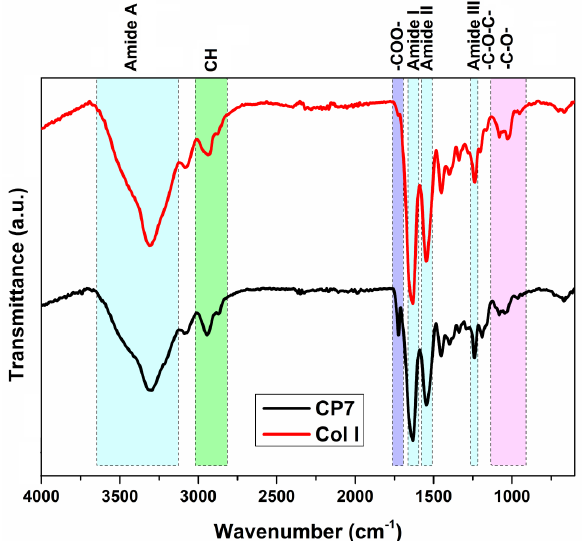
Figure 2. FTIR spectra of commercial collagen and of the CP7 sample (Entry 2, Table 1). The macroporous structure with interconnected pores of cryogel 2 (CP7, Table 1) a lower concentration of components in the reaction environment (Figure 3). A rapid increase in water absorption to equilibrium (approx. 1–3 min) can be observed in the initial stage for cryogel 2 obtained for a concentration of 2.4 wt.% of the reactants, while sample 1 synthesized at a concentration of 1.25 wt.% reached a steady state after about 7 min. The corresponding conventional hydrogel prepared at room temperature and low concentration, obtained as a rigid material, reached the equilibrium swelling after a longer time (15 min) and showed a much smaller equilibrium swelling ratio (0.47 ± 0.02) than homogeneous cryogel 2 (ESR − 14.0 ± 0.3) and even than cryogel 1, obtained for a similar concentration in feed (ESR-4.8 ± 0.08). In addition, due to a high tendency of fragmentation, the investigated rigid sample turned into small pieces when removed from the aqueous solution for weighing, after at least 75